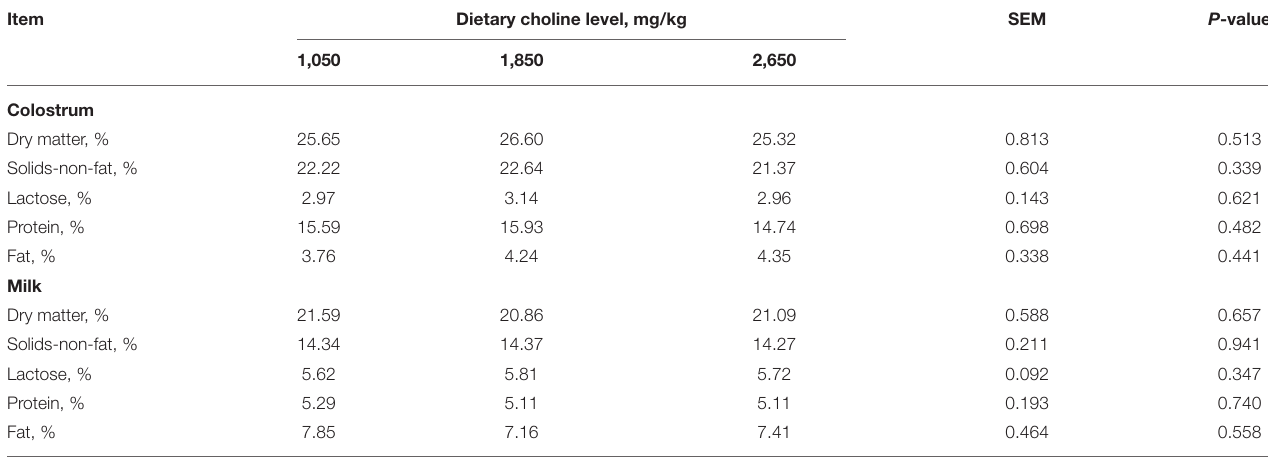
TABLE 4 | Effect of dietary choline levels during gestation on colostrum and milk composition of sows.